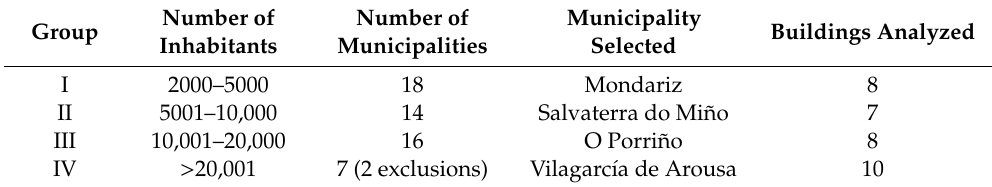
Table 3. Groups of municipalities.